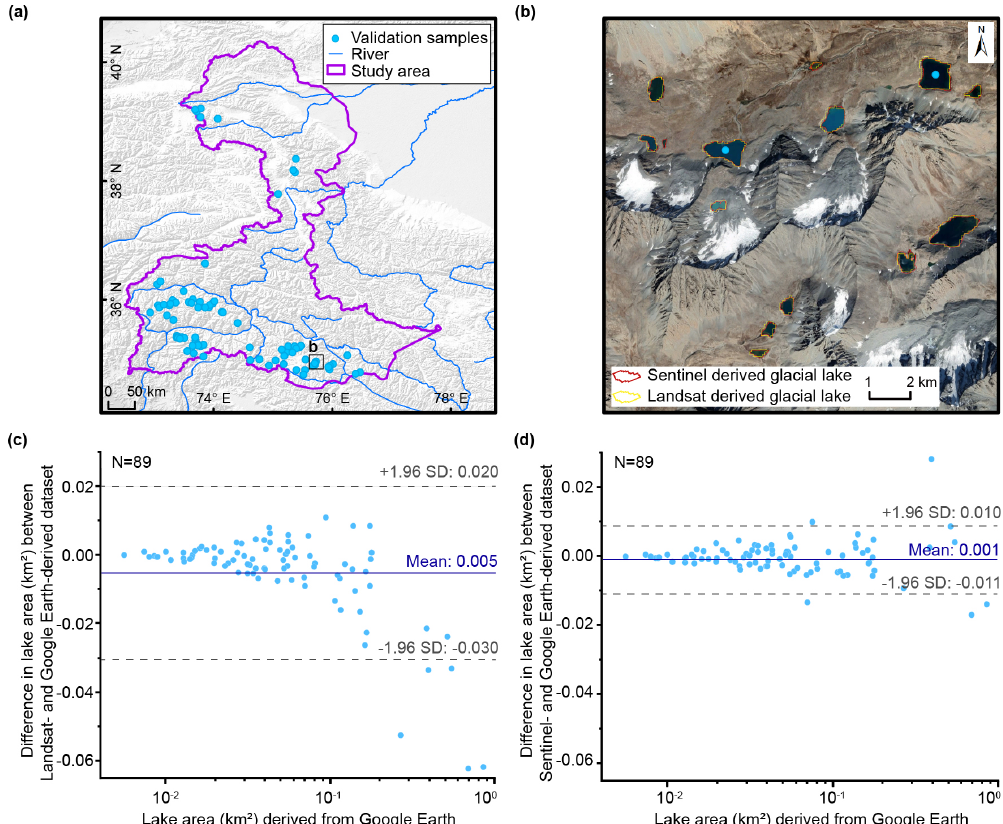
Figure 9. Distribution of the validation sample (a) , visual comparison of glacial lakes derived from Landsat and Sentinel-2 images overlaying Google Earth imagery (© Google Earth 2019) in a zoomed in site (b) , and differences between our glacial lake product (mapped from Landsat and Sentinel-2 images) and the validation reference (digitized from Google Earth at a finer scale) (c, d)